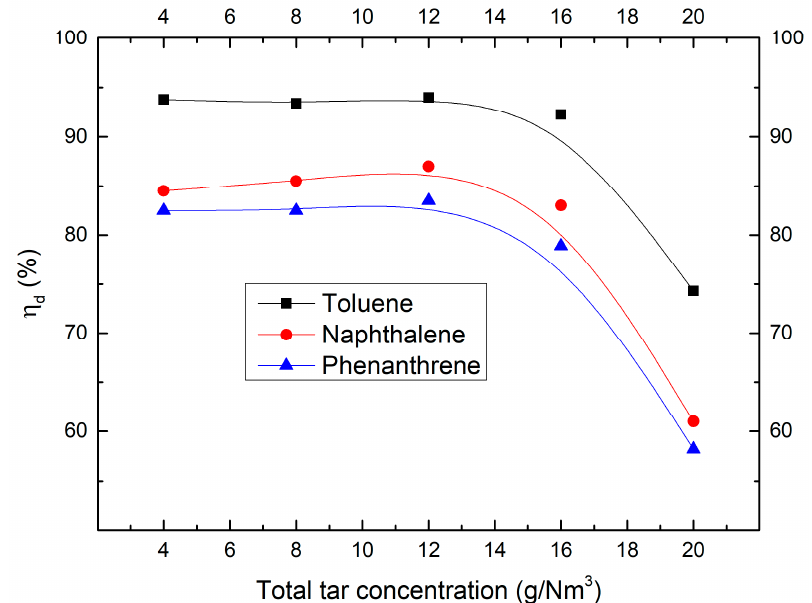
Figure 1. Effect of tar concentration on the destruction efficiency.